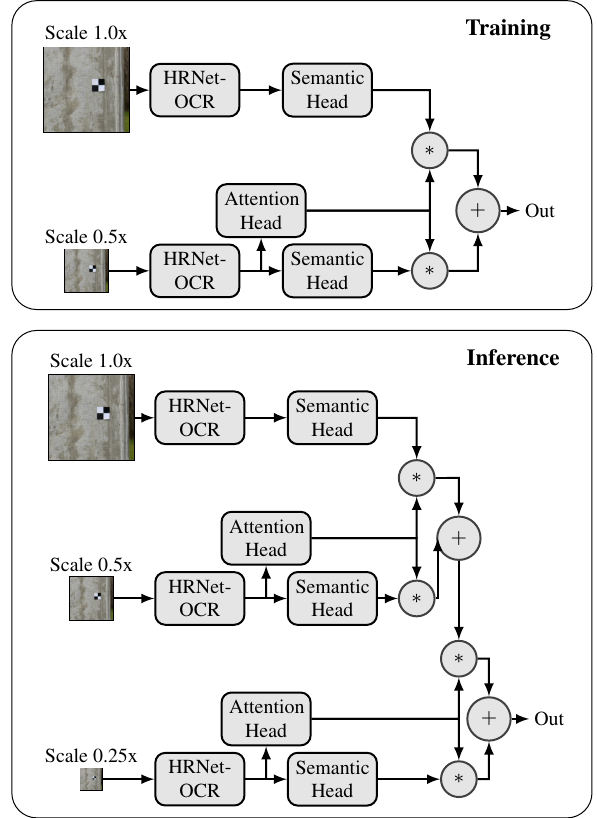
Figure 4. Depiction of the training and inference procedure of hierarchical multi-scale attention